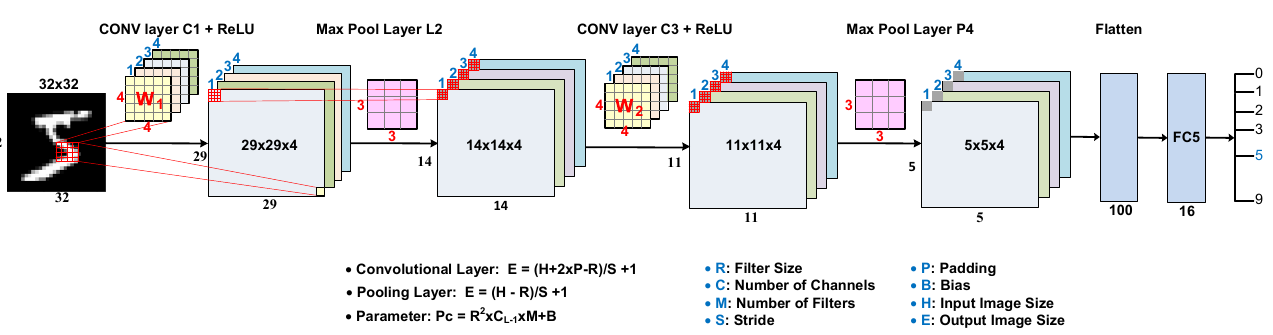
Figure 10. Detailed CNN architecture.